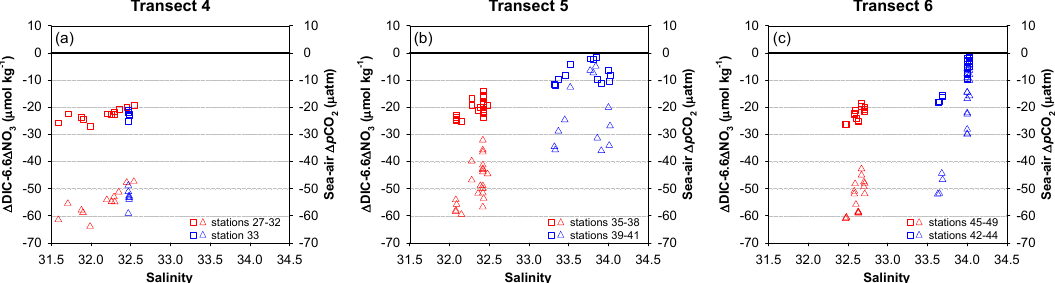
Figure 4. (cid:49) DIC − 6.6 (cid:49) NO 3 (squares) and sea–air (cid:49)p CO 2 (triangles) versus salinity in the upper waters on transects 4 (a) , 5 (b) and 6 (c) off Oregon and northern California in spring/early summer 2007. Note that data for stations 27–32 on transect 4 were obtained from waters immediately below the surface buoyant layer, while data for other stations were obtained from the surface mixed layer. The value of 6.6 is the Redfield C/N uptake ratio (approximately 106 / 16; Redfield et al., 1963). The solid line indicates the p CO 2 equilibrium between the seawater and the